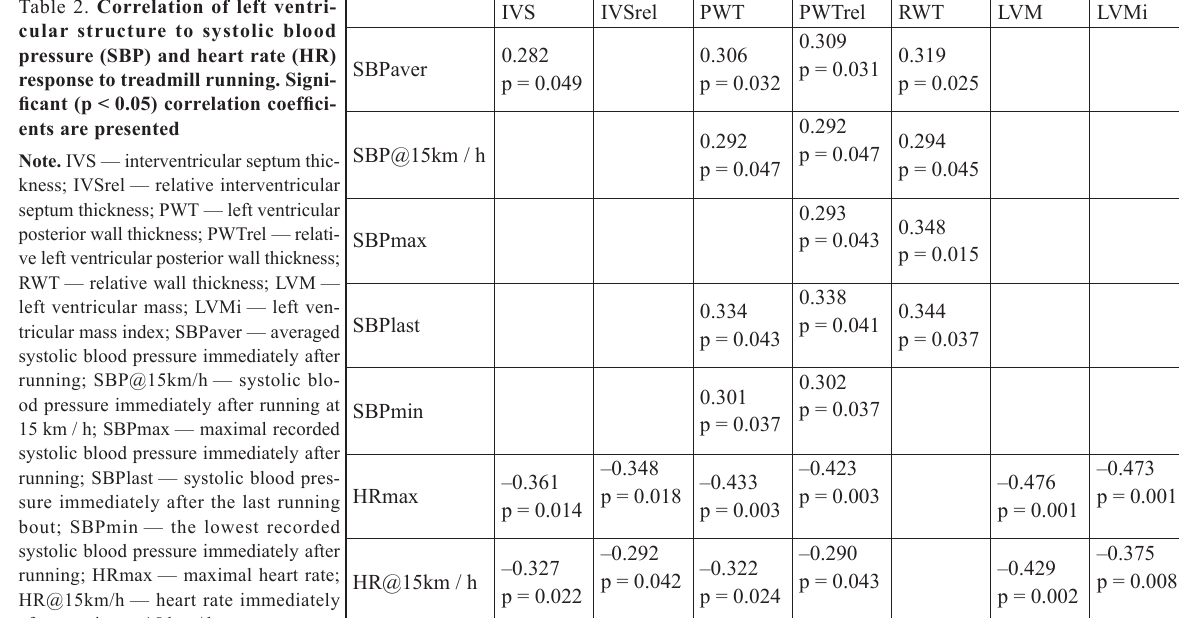
Table 2. Correlation of left ventri- cular structure to systolic blood pressure (SBP) and heart rate (HR) response to treadmill running. Signi- fi cant (p < 0.05) correlation coef fi ci- ents are